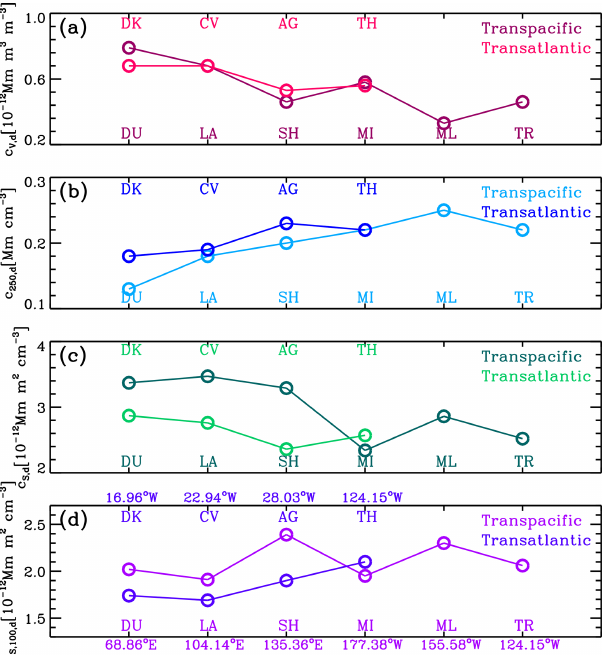
Figure 8. Variations in conversion factors (a) c v , d , (b) c 250 , d , (c) c s , d , and (d) c s , 100 , d along transoceanic dust transport paths,